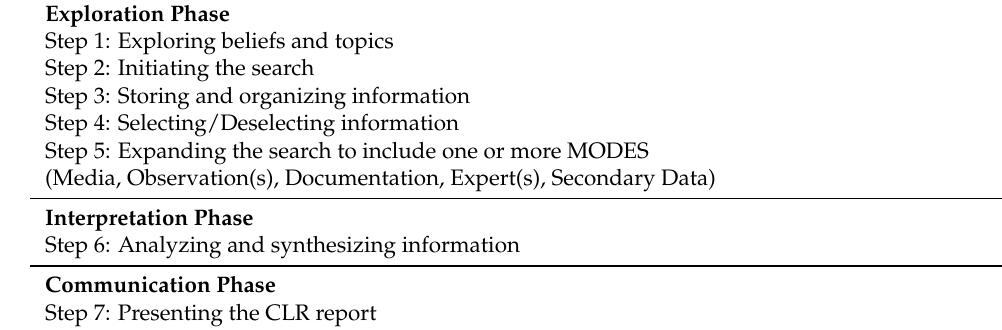
Table 1. The three phases of the Comprehensive Literature Review (CLR), from the book [36] (p. 56). Exploration